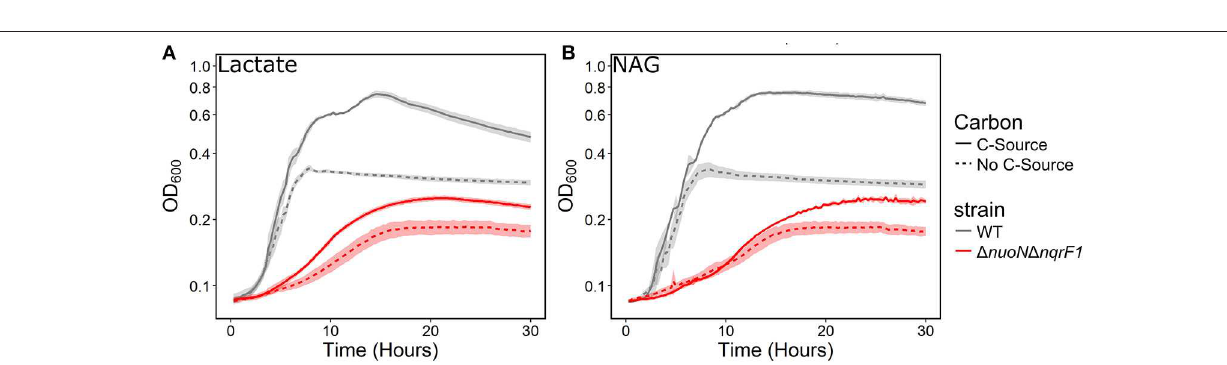
FIGURE 1 | Growth of the 1 nuoN 1 nqrF1 strain in LB (black) or M5 medium supplemented with 0.5% (w/v) (purple) and 1.0% (w/v) (orange) tryptone, and 0.5% (w/v) (cyan) and 0.25% (w/v) (light green) yeast extract in 1-mL volumes in 24-well plates at 30 ◦ C with shaking.